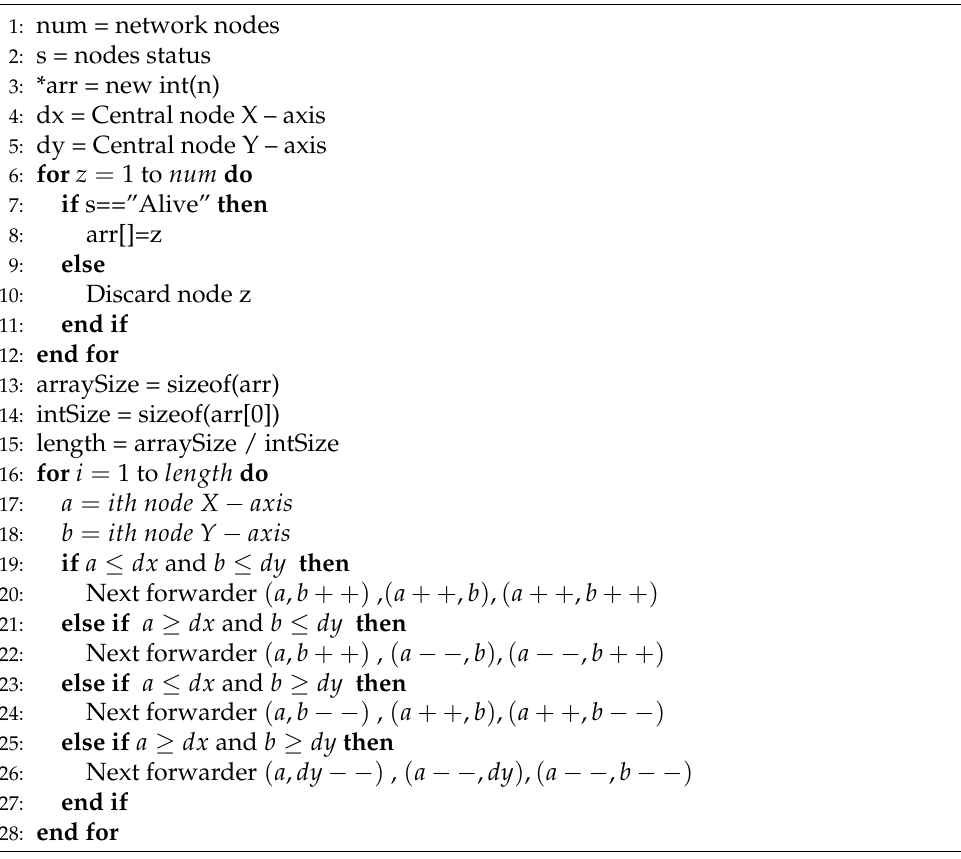
Algorithm 1 Selection of next forwarded Node